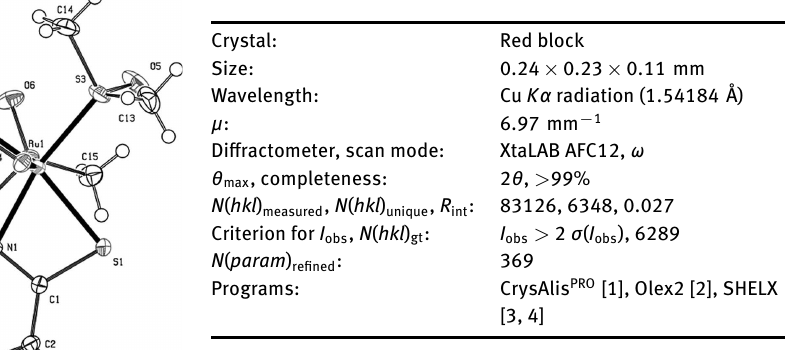
Table 1: Data collection and